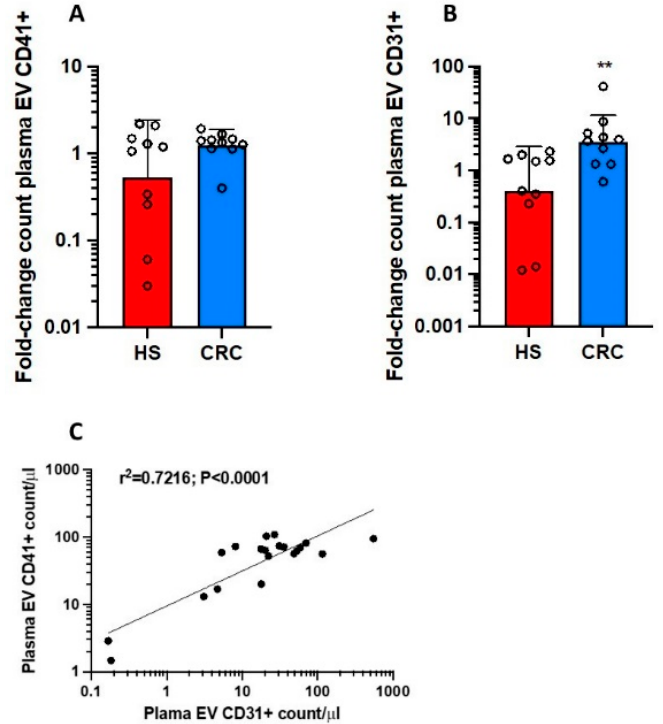
Figure 1. Changes in plasma count of medium-sized EV CD41 + or CD31 + collected from colorectal cancer (CRC) patients vs. healthy controls (HS). Plasma circulating mEVs positive for CD41 (platelet-derived) ( A ) or CD31 (vascular endothelial cell-derived) ( B ) were counted by flow-cytometry analysis, and fold-change in CRC patients vs. HS was assessed; plasma EVs were analyzed from 10 individuals with CRC and 10 healthy controls matched for sex and age; the values were not normally distributed and were transformed to logarithms, and all values are shown as scatter dot plots with mean + SD and analyzed by a two-tailed Student’s t -test, ** p < 0.01 vs. HS. ( C ) The log-transformed plasma count of mEV CD31 + and CD41 + fitted a linear regression model.